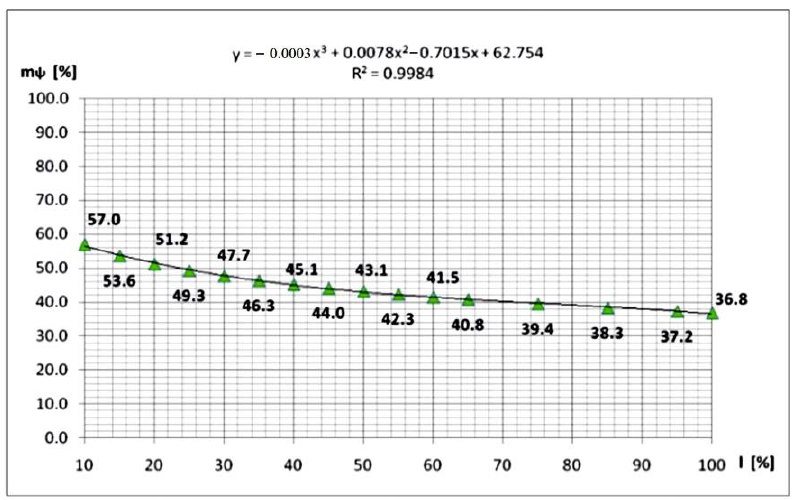
Figure 26. The relative [%]m